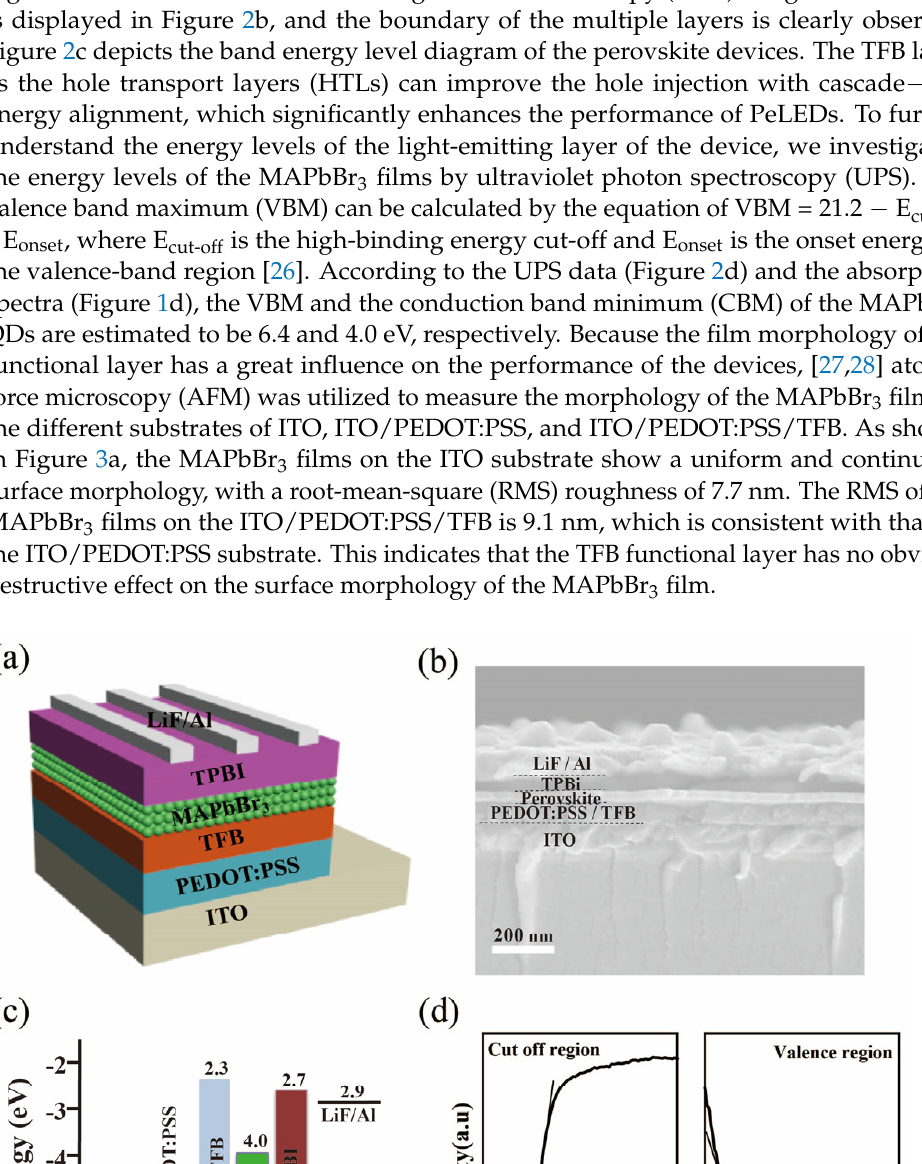
Figure 2a. The cross-sectional scanning electron microscopy (SEM) image of the PeLED is displayed in Figure 2b, and the boundary of the multiple layers is clearly observed.